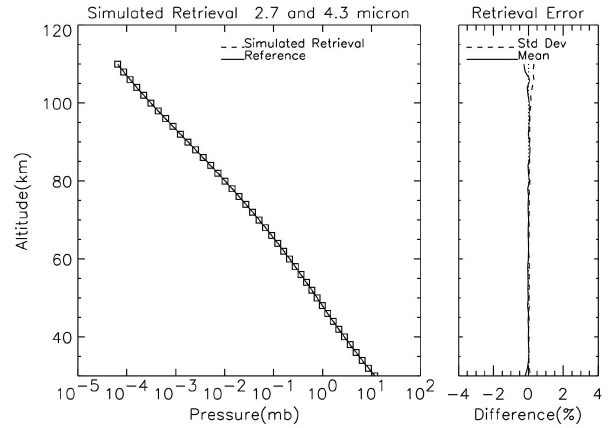
Fig. 20. Same as Fig. 19 but for